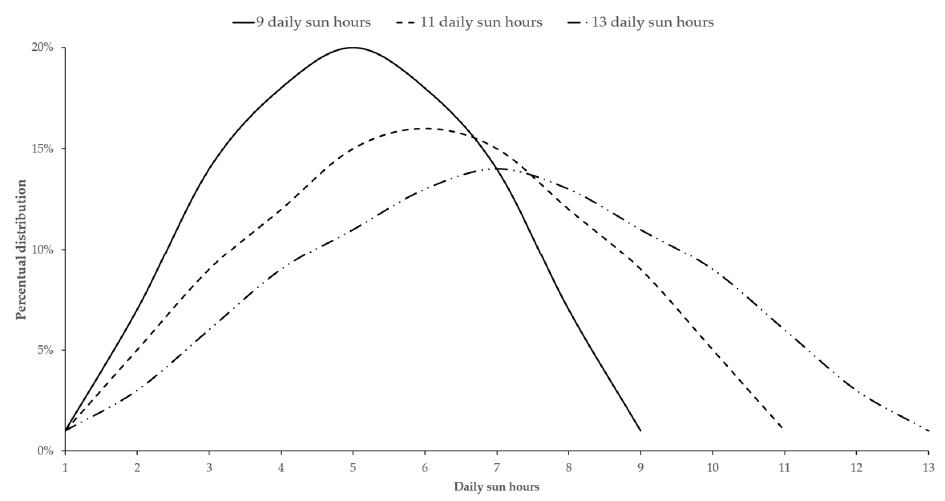
Figure 5. Percentage distribution of PV production for the months with 9, 11, and 13 h of sunlight per day. Table 4 presents the estimated values based on the presented methodology. Table 4. Hourly estimated production.